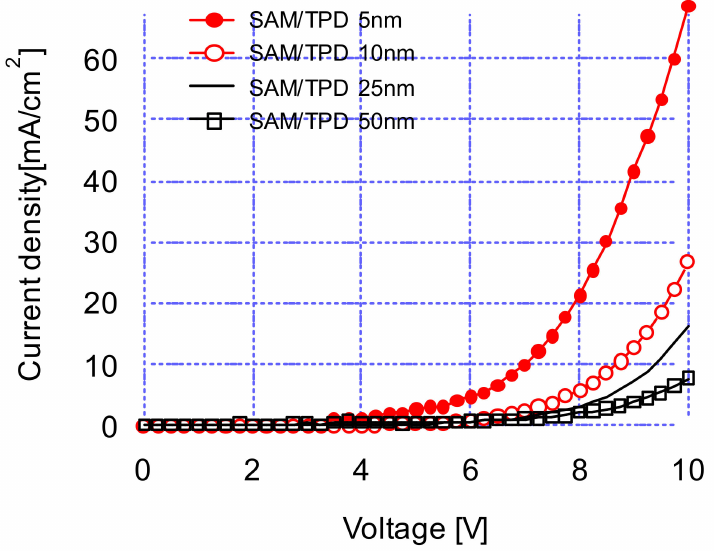
Figure 1. Current density-voltage characteristics of OLED devices at 5, 10, 25, 50 nm TPD thicknesses.